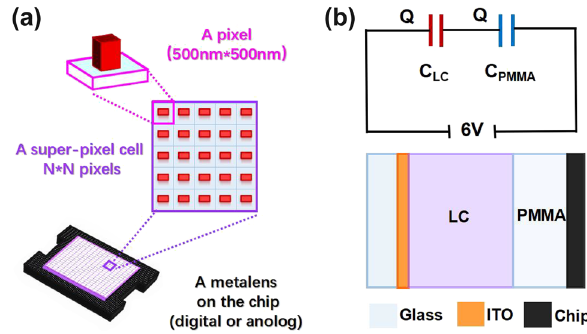
Figure 4: Schematic illustration of the super-pixel cell layout and the equivalent capacitance model. (a) Schematic of the super-pixel cell and the integrated configuration of the metalens. (b) Schematic of the equivalent capacitance model for analyzing the insulation layer’s